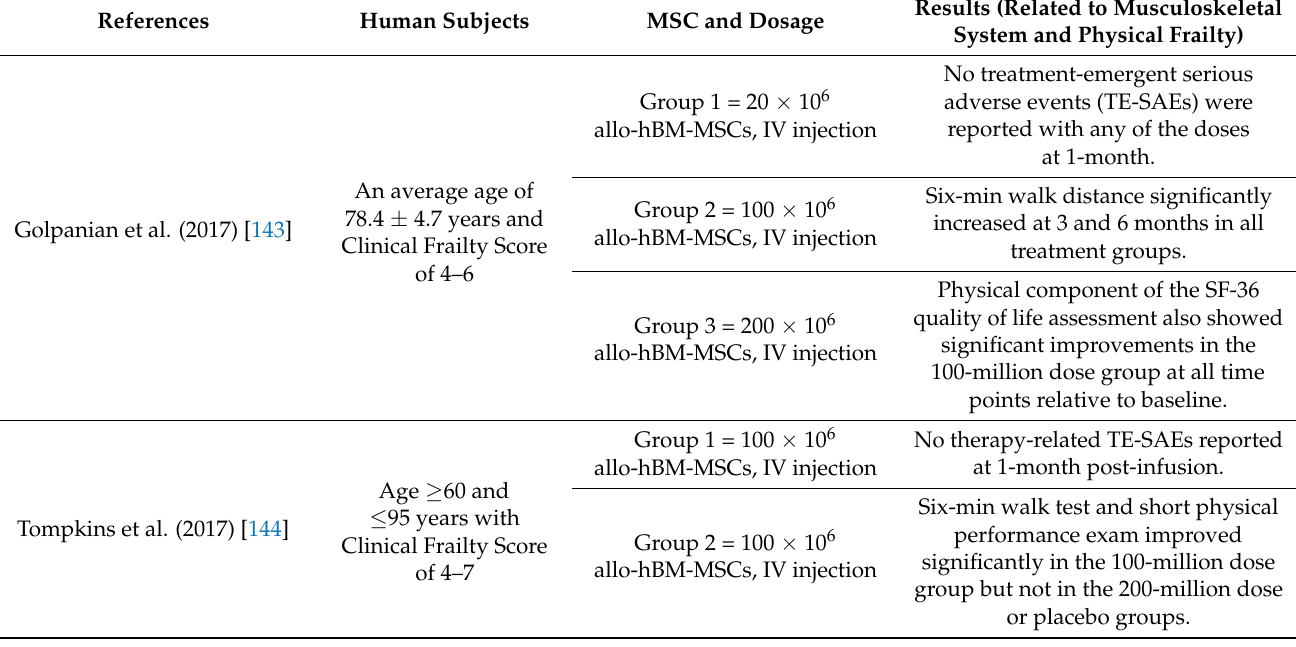
Table 2. A summary of clinical studies of MSC effects on the musculoskeletal system in frail older